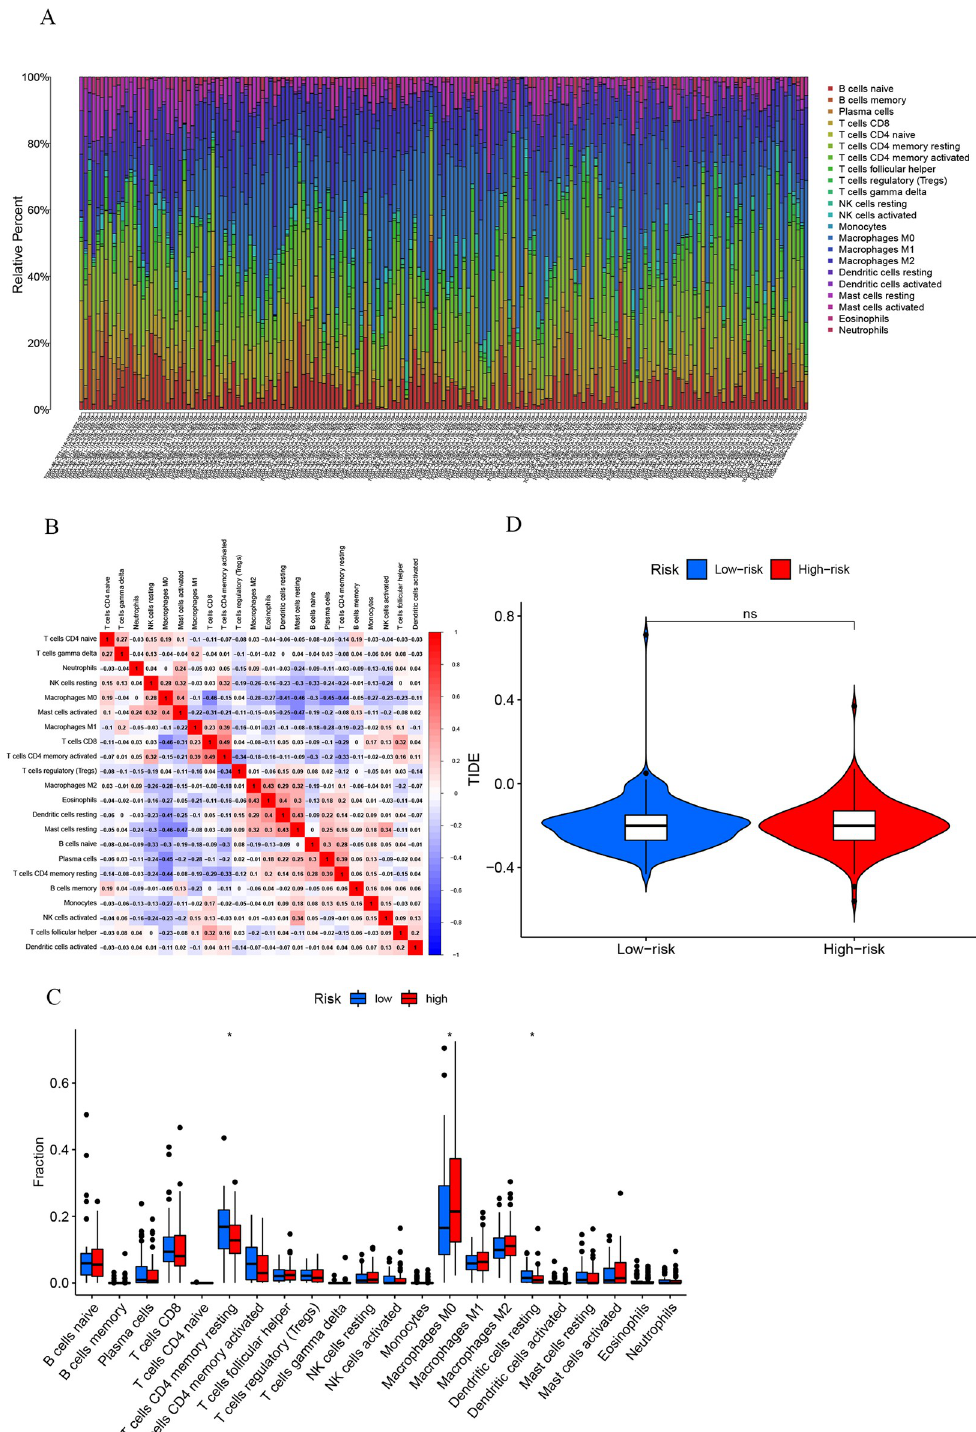
Fig 8. (A) Estimated scores of 22 immune cell subtypes. Each bar chart represents cell proportions in each patient, and different colors represent each subtype. (B) Correlation between the 22 subtypes of immune cell. (C) Results of analysis comparing the fraction of immune infiltrating cells between high- and low-risk groups. (D) Analysis of immunotherapy; the vertical coordinates represents the TIDE score, abscissa represent high- and low-risk groups ( * P < 0.05, nsP > 0.05).